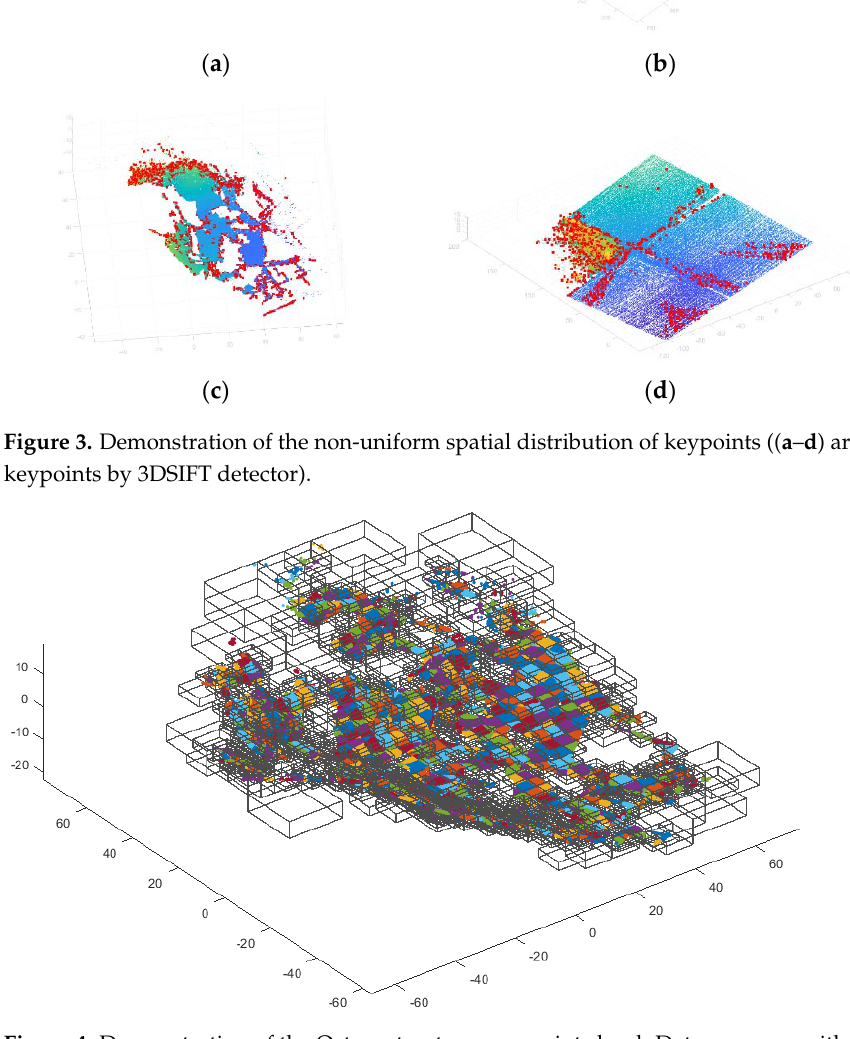
Figure 4. Demonstration of the Octree structure on a point cloud. Data are same with Figure 3d.